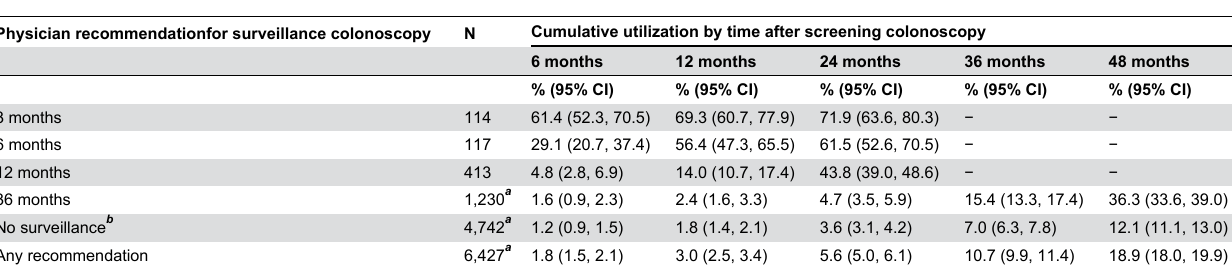
Table 2. Utilization of additional colonoscopies up to 4 years after screening colonoscopy.